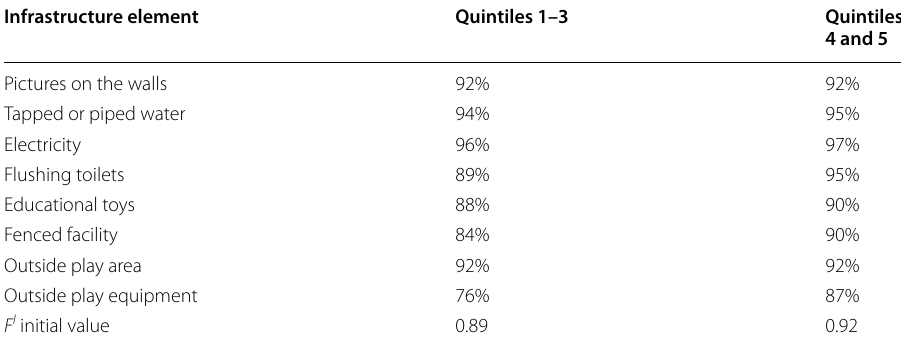
Table 4 Percentage of children per socio-economic quintile, where the necessary infrastructure is present Infrastructure element